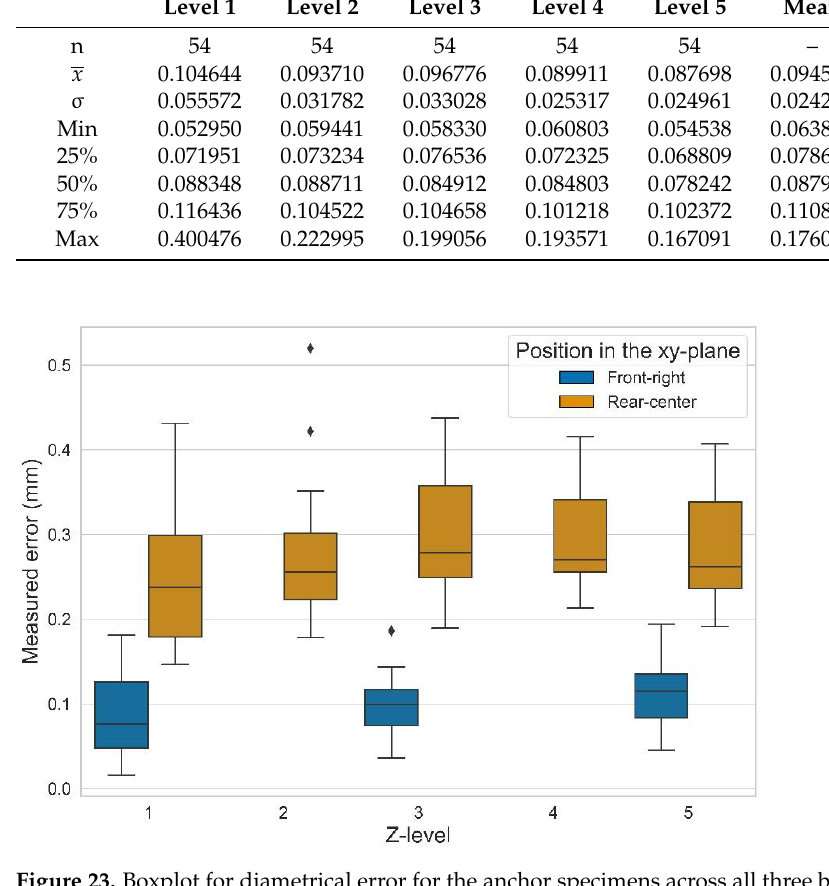
( b ) Figure 24. Boxplot for measured flatness error of vertical planes at different positions. ( a ) The rows along the x-axis at different z-levels; ( b ) the rows along the y-axis at different z-levels. 4. Discussion The described experiment is designed, planned, and executed to produce repeatable and valid results. By developing a rigid methodology and performing automated data